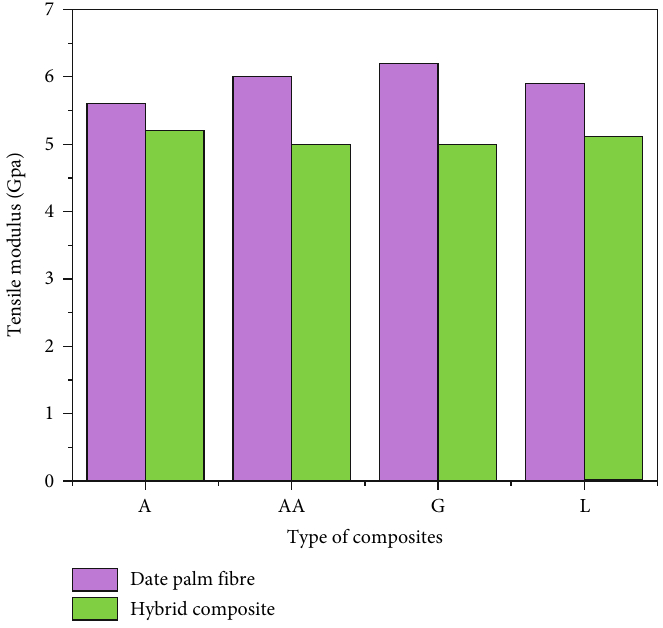
Figure 7: Tensile modulus of DPF with hybrid